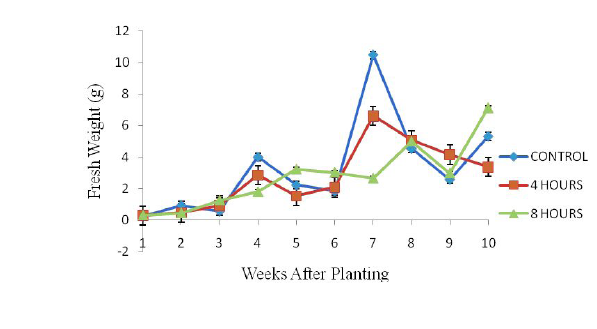
Fig. 6. Effect of prior heat stress on the accumulation of chloro- phyll b in C.